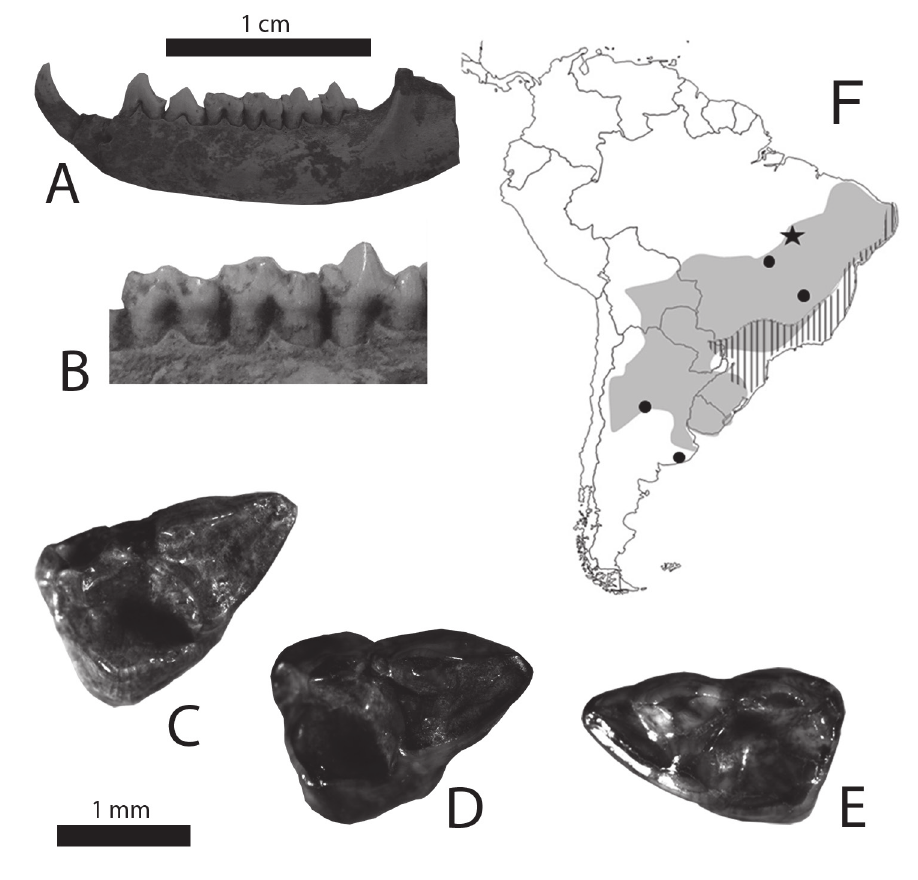
Figure 2 - Selected specimens of Didelphis from Gruta dos Moura and its revised geographic distribution for the Pleistocene. A. An almost complete left dentary of Didelphis cf. albiventris (UNIRIO-PM1209) in labial view. B. A detail view of molar series of the left dentary of Didelphis cf. albiventris (UNIRIO-PM1209) in labial view. Note the great wear mainly in the m1 and m2. Scale: 1cm. C. Left dp3 of Didelphis cf. aurita (UNIRIO-PM1206) in occlusal view; D. Left dp3 of Didelphis cf. aurita (UNIRIO-PM1208) in occlusal view; E. Right dp3 of Didelphis cf. aurita (UNIRIO-PM1207) in occlusal view. Scale 1mm. Geographic F. Distribution of Didelphis aurita and D. albiventris . Gray area is the geographic distribution of the extant Didelphis albiventris . Area with vertical lines is the geographic distribution of the extant Didelphis aurita. Black star marks the Gruta dos Moura cave locality. Black circles mark Pleistocene records of Didelphis albiventris. (Gardner 2008, Winge 1893, Salles et al. 1999, Cartelle